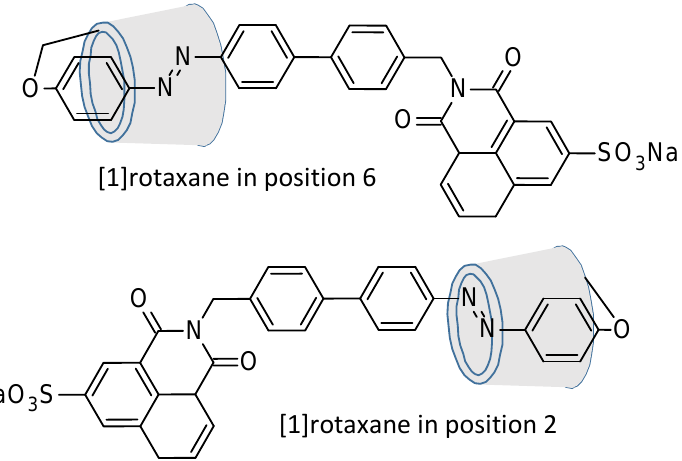
Figure 19. Roraxanes from Ma et al.